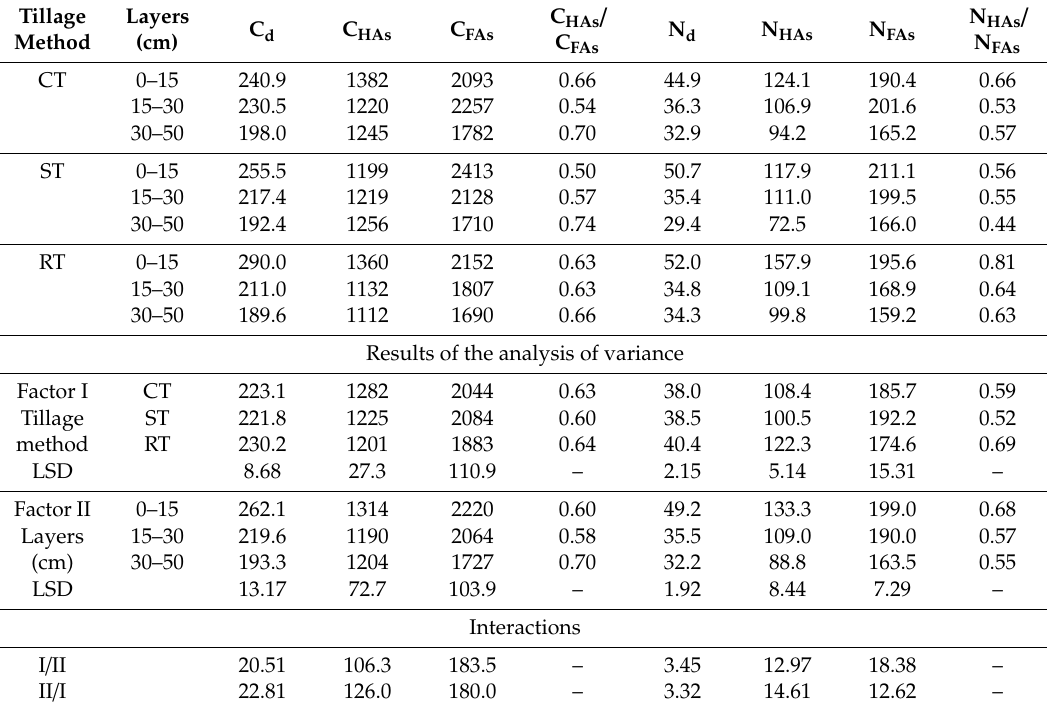
Table 2. Content of carbon and nitrogen (mg kg − 1 ) in the humus fraction and the results of the analysis of